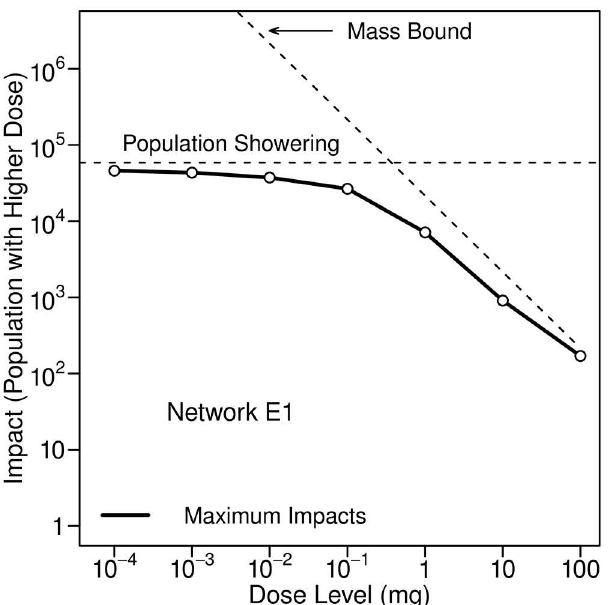
Fig 14. Example of bounds on inhalation impacts associated with showering. Results are for Network E1 and 10 kg of a volatile contaminant injected at 0:00 hours.